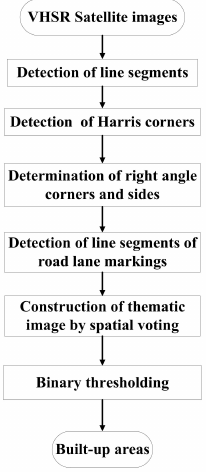
Figure 1. Flowchart of the proposed